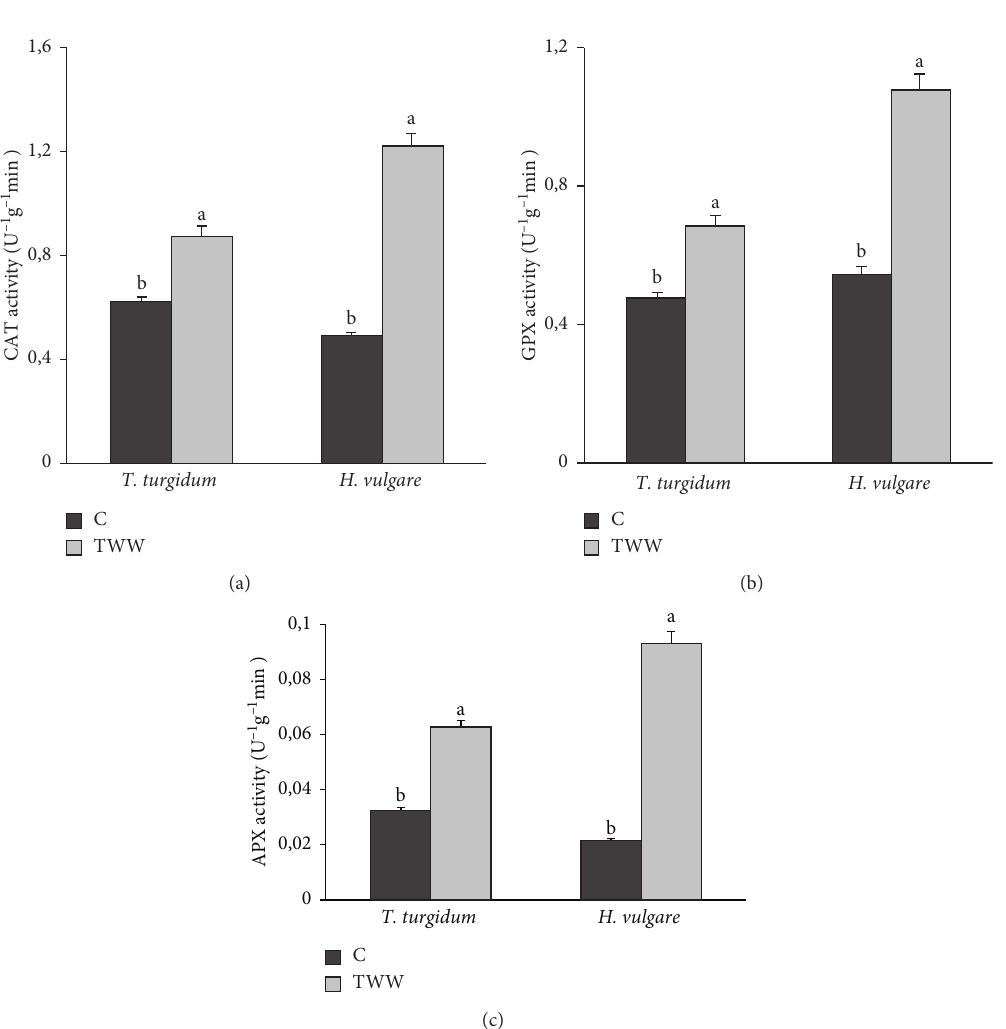
Figure 5: Activities of CAT (a), GPX (b), and APX (c) in the leaves of T. turgidum and H. vulgare cultured in control soils and wastewater irrigated soils. Means of four replicates. Bars marked with the same letter are not significantly different at p < 0 .